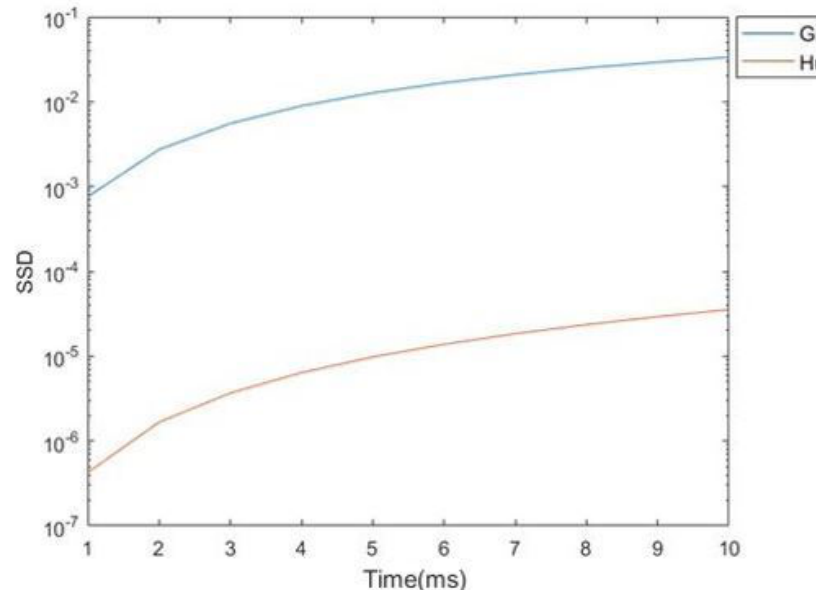
Figure 2. The SSD of gray and hue varying with different lighting